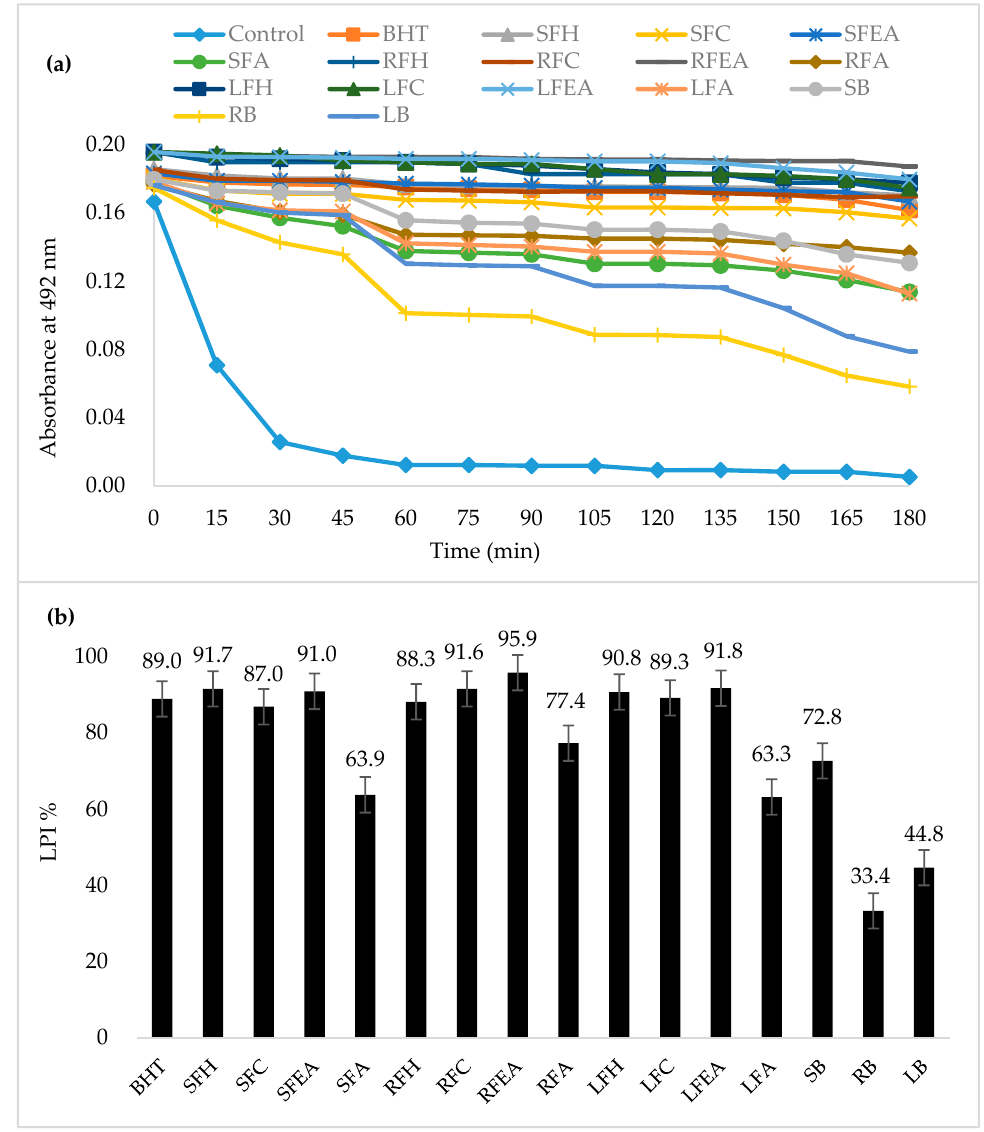
Figure 2. Antioxidant activity of Phal. Sogo Yukidian “V3” orchid sample extracts measured by β -carotene bleaching method ( a ) and their lipid peroxidation inhibition (%LPI) ( b ) Control (MeOH); BHT: Butylated hydroxytoluene. SFH: Stem free hexane, SFC: Stem free chloroform, SFEA: Stem free ethyl acetate, SFA: Stem free aqueous, RFH: Root free hexane, RFC: Root free chloroform, RFEA: Root free ethyl acetate, RFA: Root free aqueous, LFH: Leaf free hexane, LFC: Leaf free chloroform, LFEA: Leaf free ethyl acetate, LFA: Leaf free aqueous, SB: Stem bound, RB: Root bound, LB: Leaf bound.